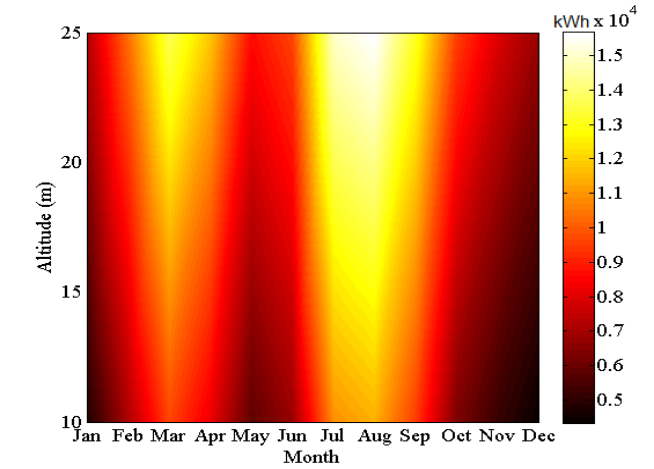
Figure 7. Monthly energy production of the micro wind power plant